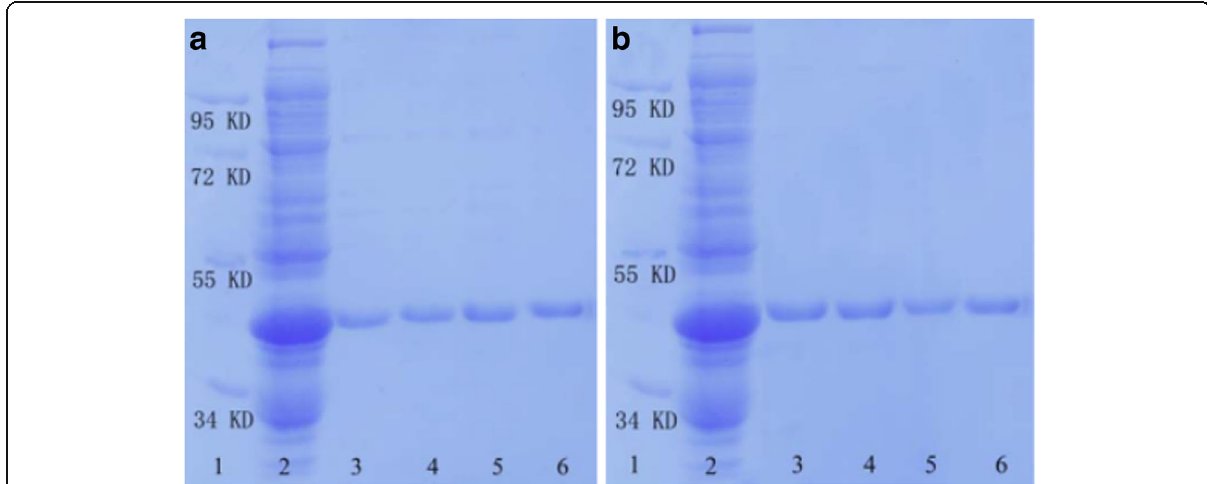
Fig. 4 SDS-PAGE analysis of purified GST-tagged proteins separated by SnO 2 /SiO 2 -GSH NSs. a Lane 1, marker; lane 2, E. coli lysate; lanes 3 – 6 refer to the fractions washed off from the SnO 2 /SiO 2 -GSH NSs with different concentrations of GSH solution (lane 1, 10 mmol/L; lane 2, 20 mmol/L; lane 3, 50 mmol/L; lane 4, 100 mmol/L). b Lane 1, marker; lane 2, E. coli lysate; lane 3, 1st separation; lane 4, 2nd separation; lane 5, 3rd separation; and lane 6, the fractions washed off from the Glutathione Sepharose